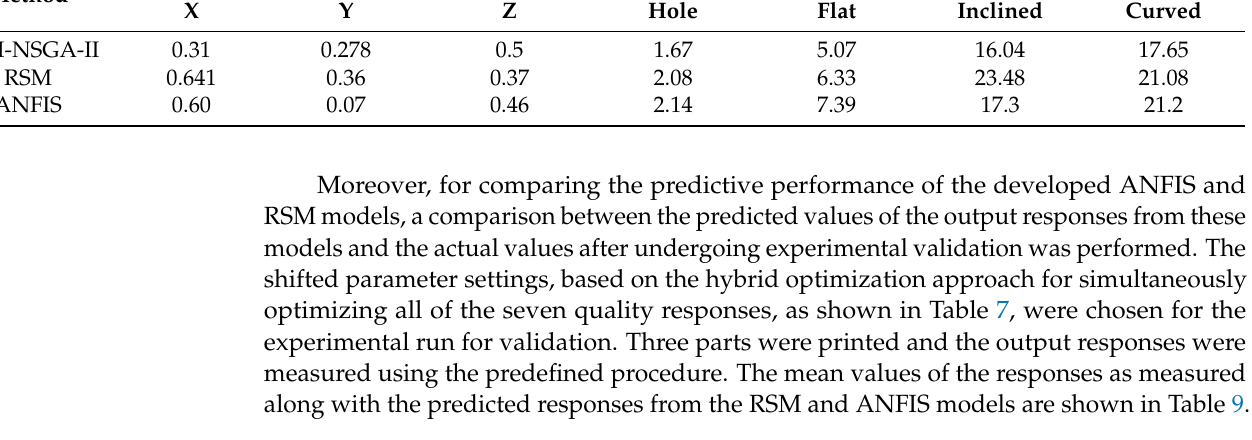
Table 9. Comparison of part quality between experimental validation and model